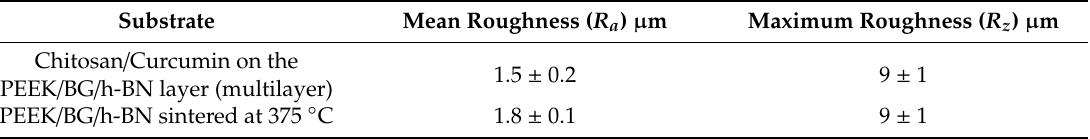
Table 2. Roughness measurements for PEEK / BG / h-BN coatings sintered at 375 ◦ C and for chitosan / curcumin coating on the PEEK / BG / h-BN